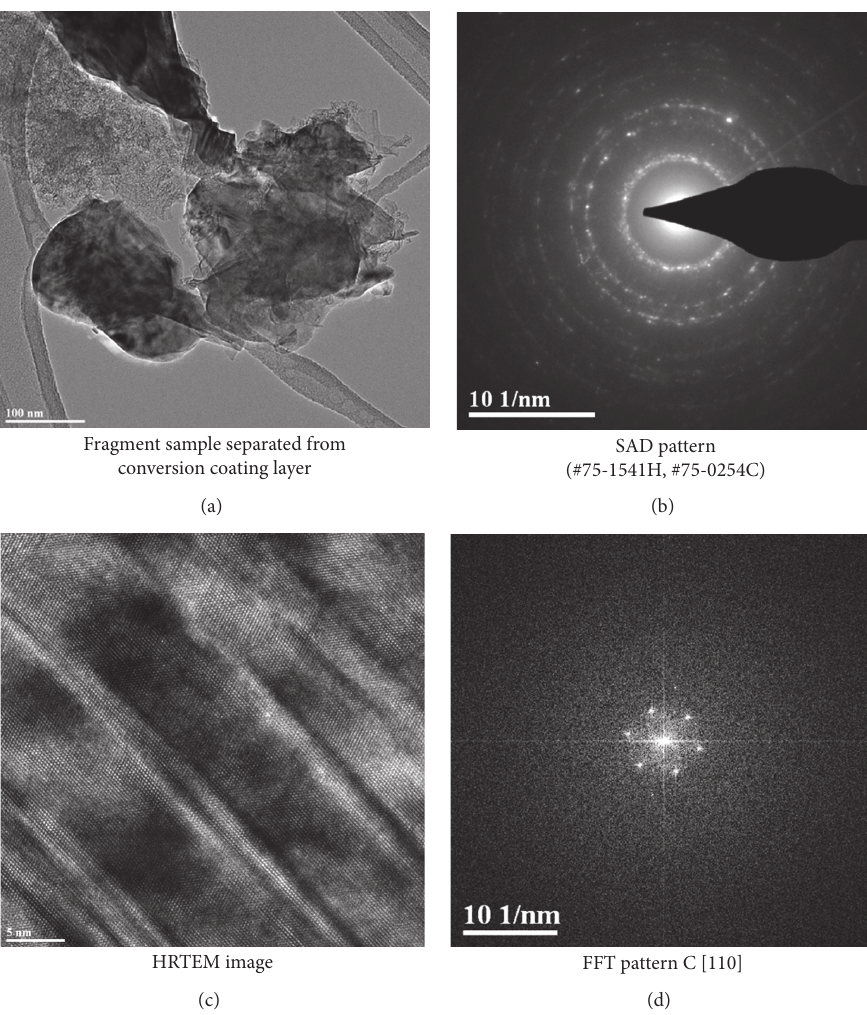
Figure 5: FE-TEM images and diffraction patterns of SiC conversion